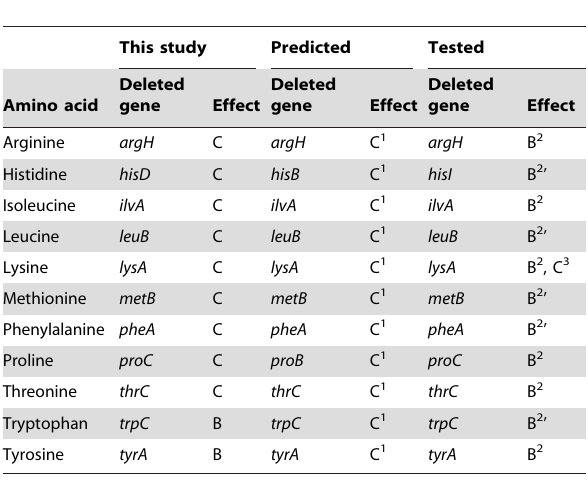
Table 3. Comparison of the single-gene deletions that were identified in this study to result in specific amino acid auxotrophies of E. coli with published information on predicted and empirically tested amino acid